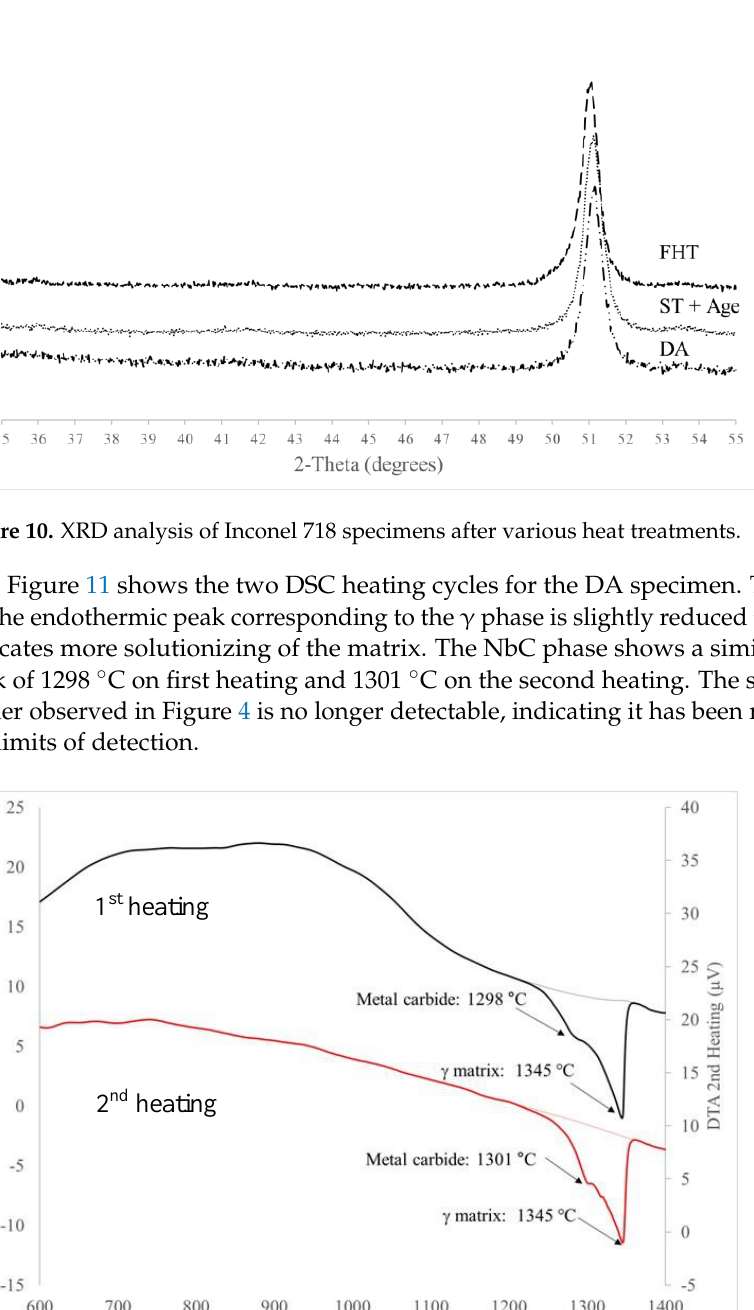
Figure 9. IQ map of columnar structures ( a ) and the corresponding TKD phase distribution map showing the γ (or FCC) matrix in red and the Laves phase in green ( b ).